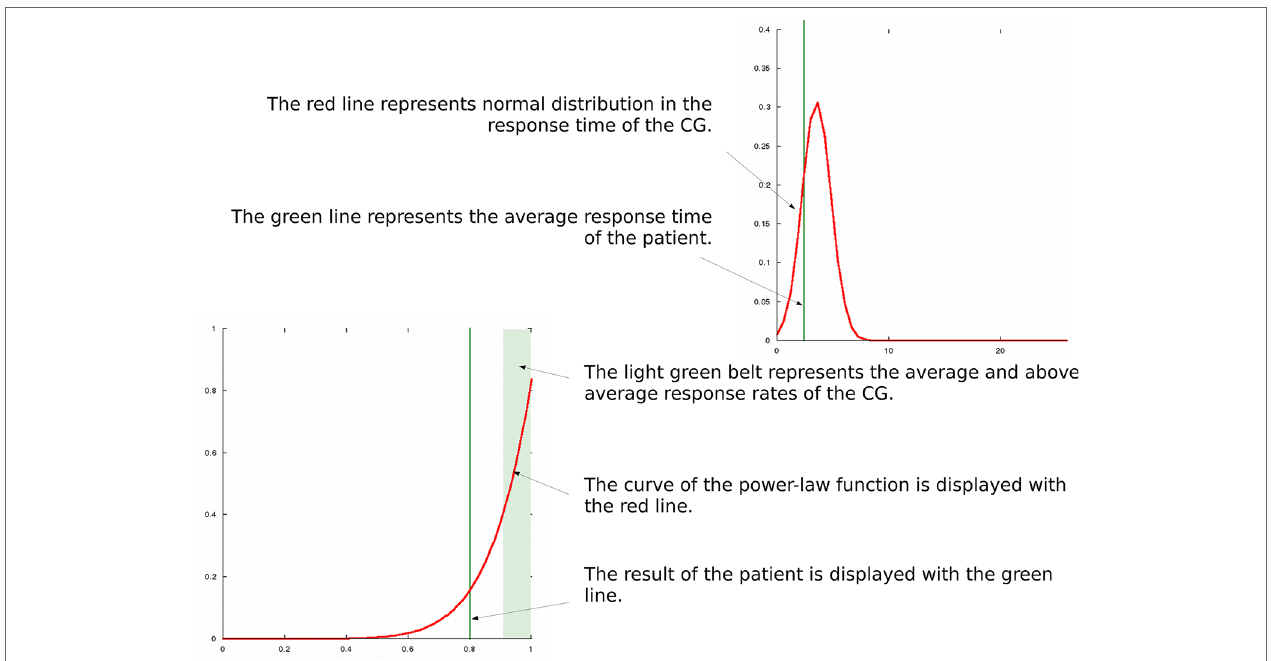
FIgURe 5 | Graphical results of a patient in the irony condition displayed by